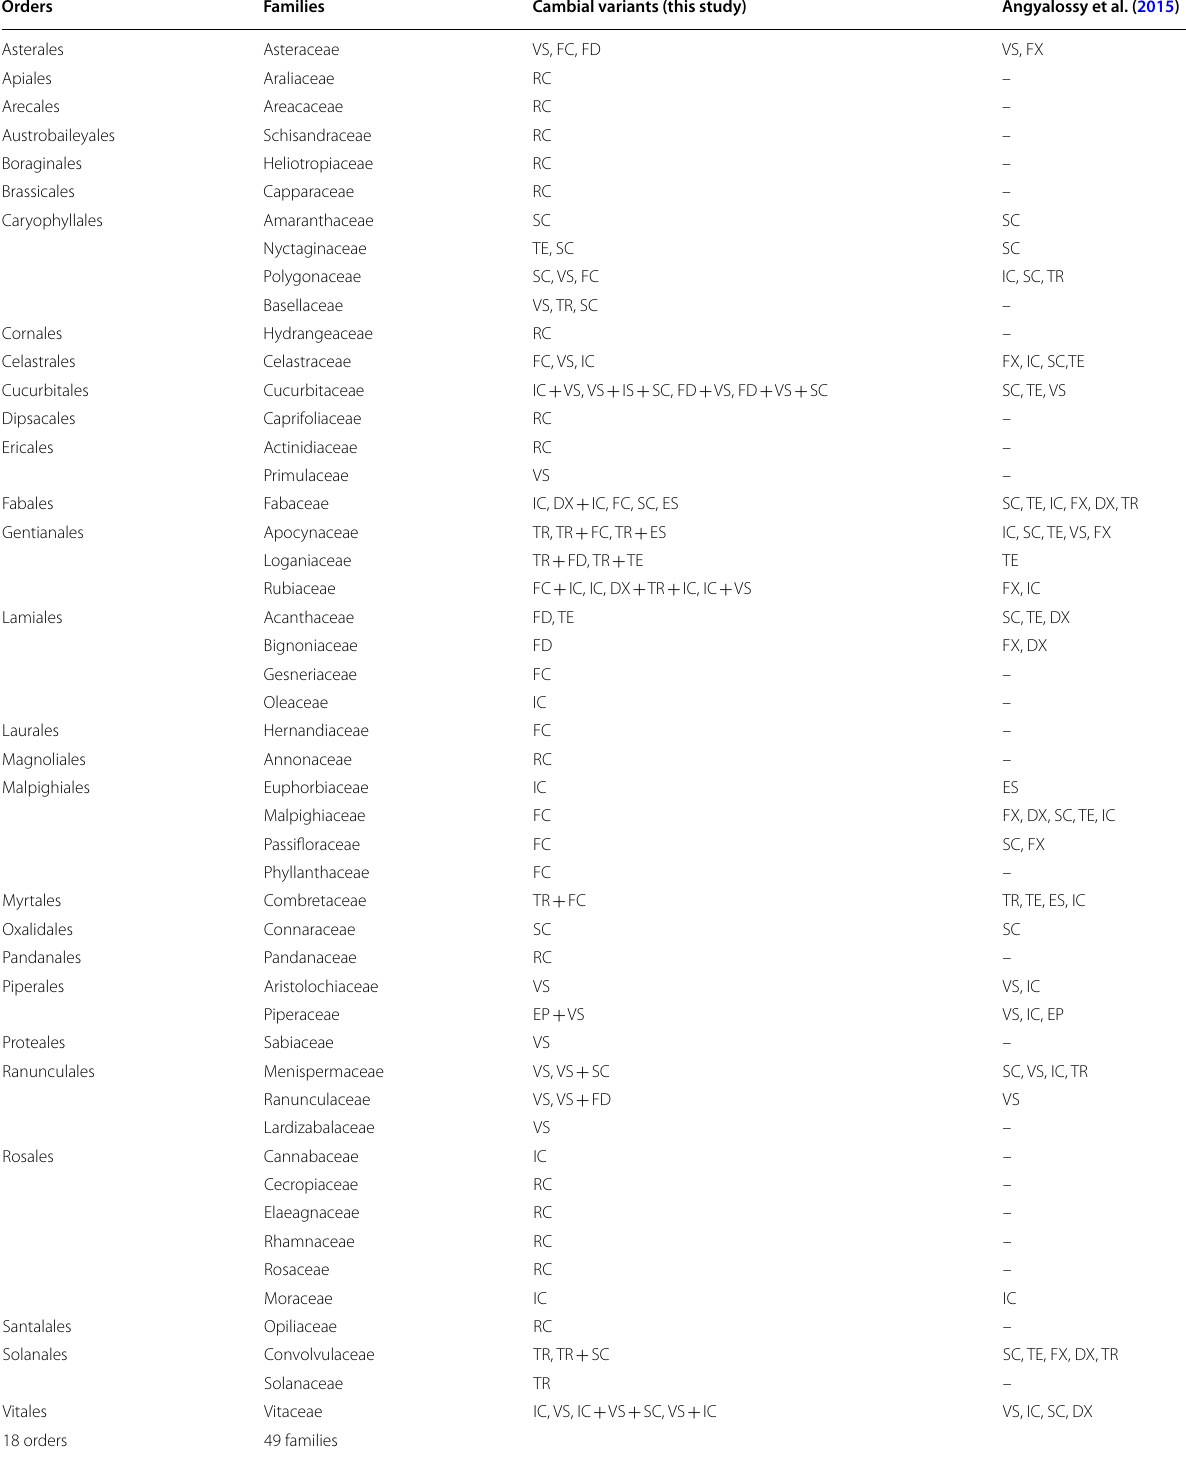
Table 3 List of orders and families of Taiwan lianas that possess the cambial